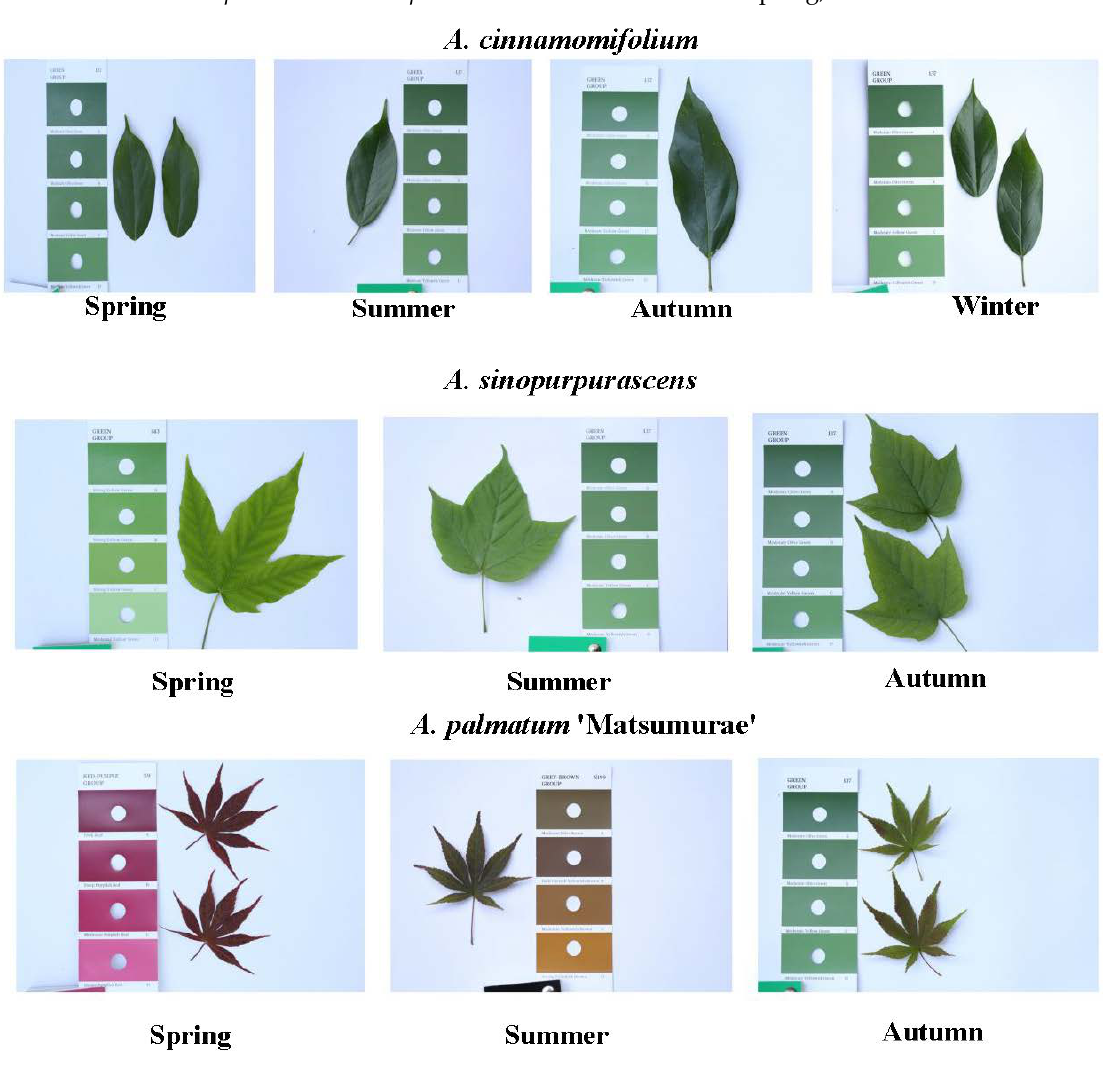
Figure 5. Digital photographs of A. cinnamomifolium in four seasons, and representative digital pho- tographs of A. sinopurpurascens and A. palmatum ‘Matsumurae’ in the spring, summer and